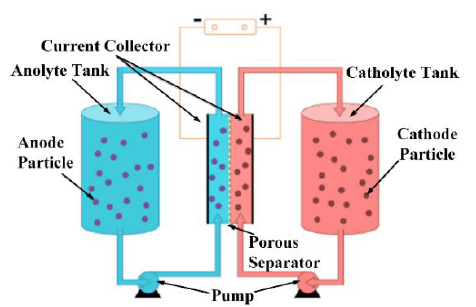
Figure 57. Schematic illustration of Type III RFB design, where flowing active material particles collide on current collectors without carbon [161].